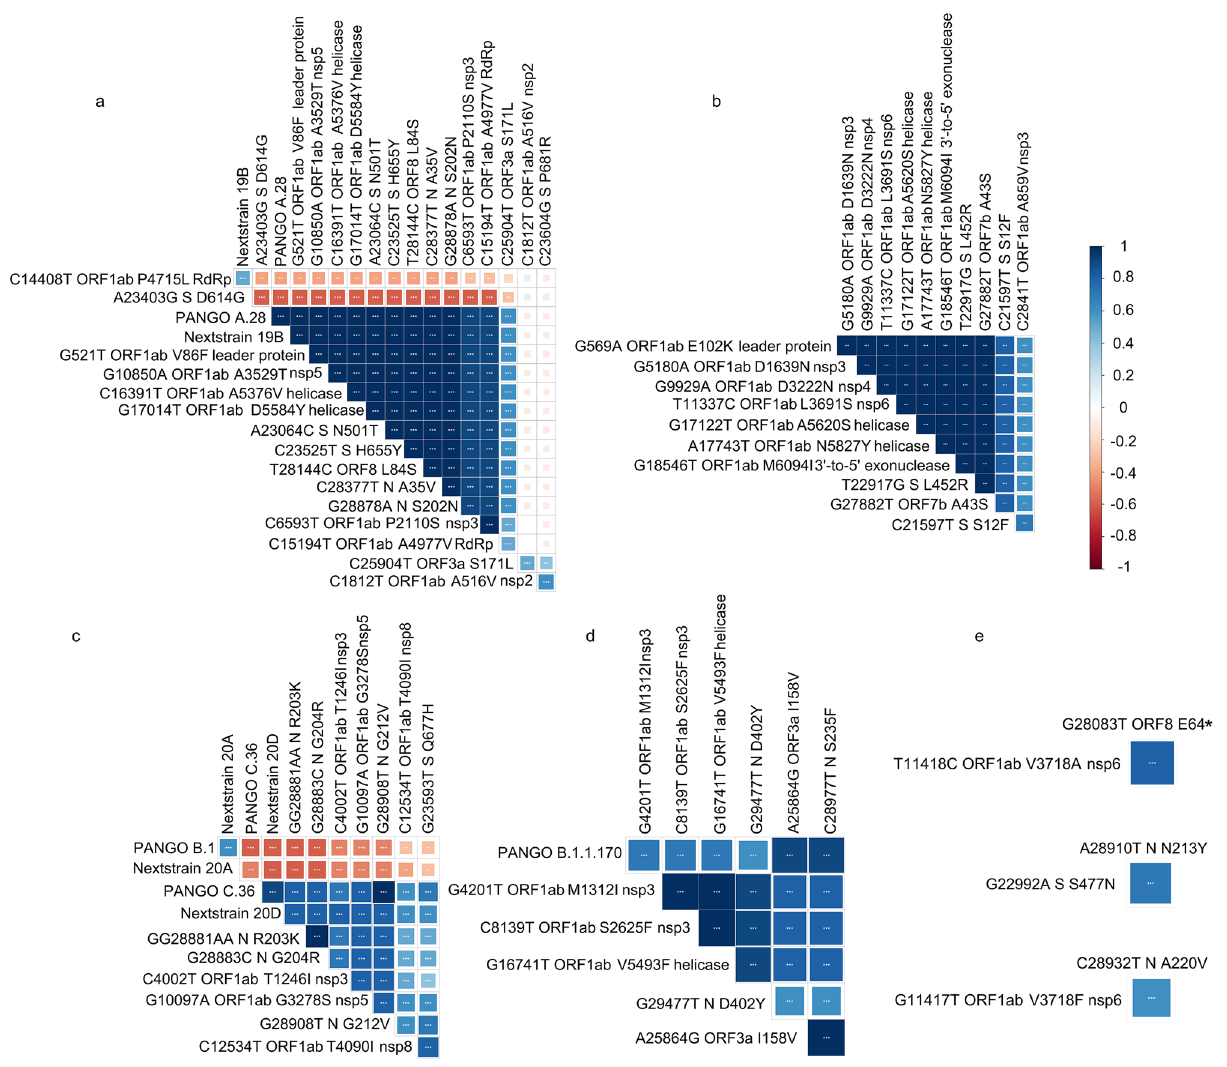
Figure 4. Correlations between different mutations shown by linkage